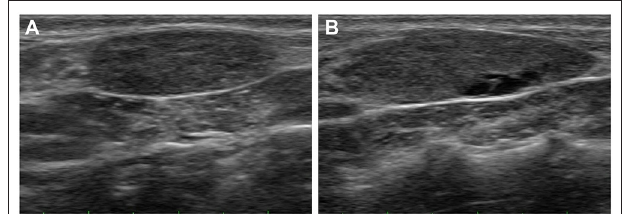
FIGURE 1 | Ultrasonograms of the goiter caused by iodine deficiency in the dog. The echotexture of the left thyroid lobe (A) is homogeneous, whereas the echotexture of the right lobe (B) is heterogenous with some anechoic lesions. Both thyroid lobes are mildly enlarged and well marginated without invasion.